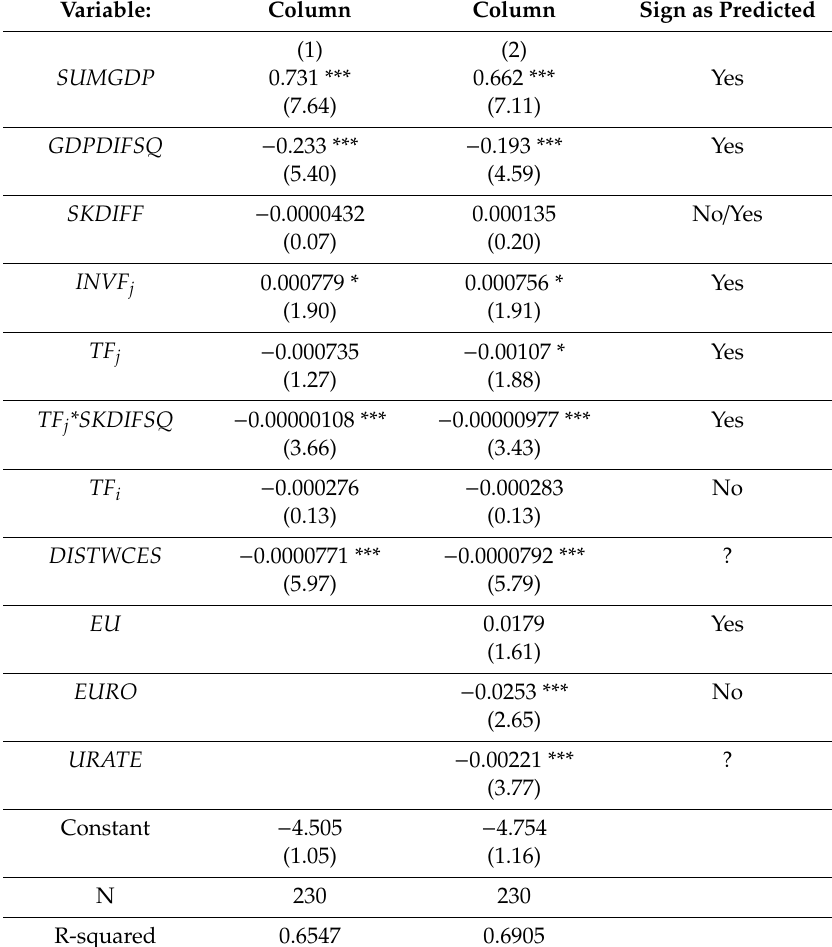
Table 2. Pseudo Poisson Maximum Likelihood (PPML) Estimation Results for the baseline and extended Knowledge-Capital (KK)